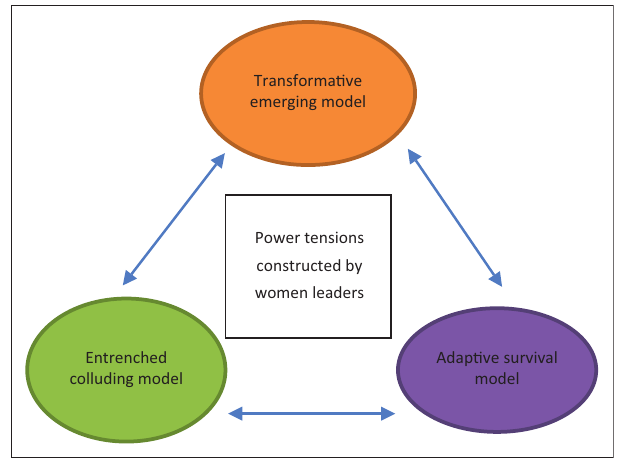
FIGURE 2: Power tensions: Constructions of power of women